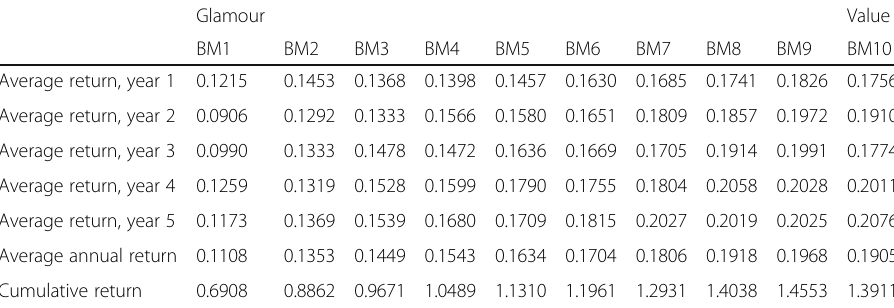
Table 1 Average returns, book-to-market portfolios. Ten portfolios are formed using book-to-market data at the end of April for each year in the 33-year period between 1968 through 2000 for all AMEX and NYSE stocks identified on CRSP, following the methodology detailed in Lakonishok et al. (1994). For each year, returns are extracted for the subsequent 60-month period. Annual return is then calculated using these monthly returns for May through April of each of the five post-portfolio formation years. If a stocks monthly returns disappear then the investor is assumed to invest for the remainder of the year in a randomly chosen stock within the same decile grouping on the basis of market capitalization. Book-to-market is calculated as the book value of the stock for the fiscal year prior to the test year divided by the market value of the stock for April of the test year. The average values across the 33 years in the sample of the annual returns are reported in this table for each of the five post-portfolio formation years. As well, the average annual return and cumulative return are reported for each book-to-market group. “ Glamour ” and “ Value ” refer to the groups with the lowest and highest values of book-to-market, respectively Glamour Value BM1 BM2 BM3 BM4 BM5 BM6 BM7 BM8 BM9 BM10 Average return, year 1